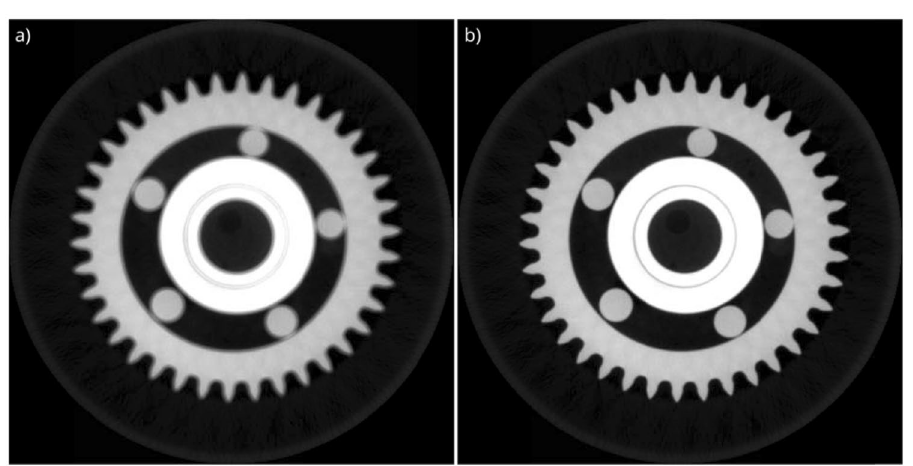
Figure 4. The reconstruction results of the ball bearing. For the reconstruction, the center of rotation and the detector offset correction modules are ( a ) disabled, and ( b )